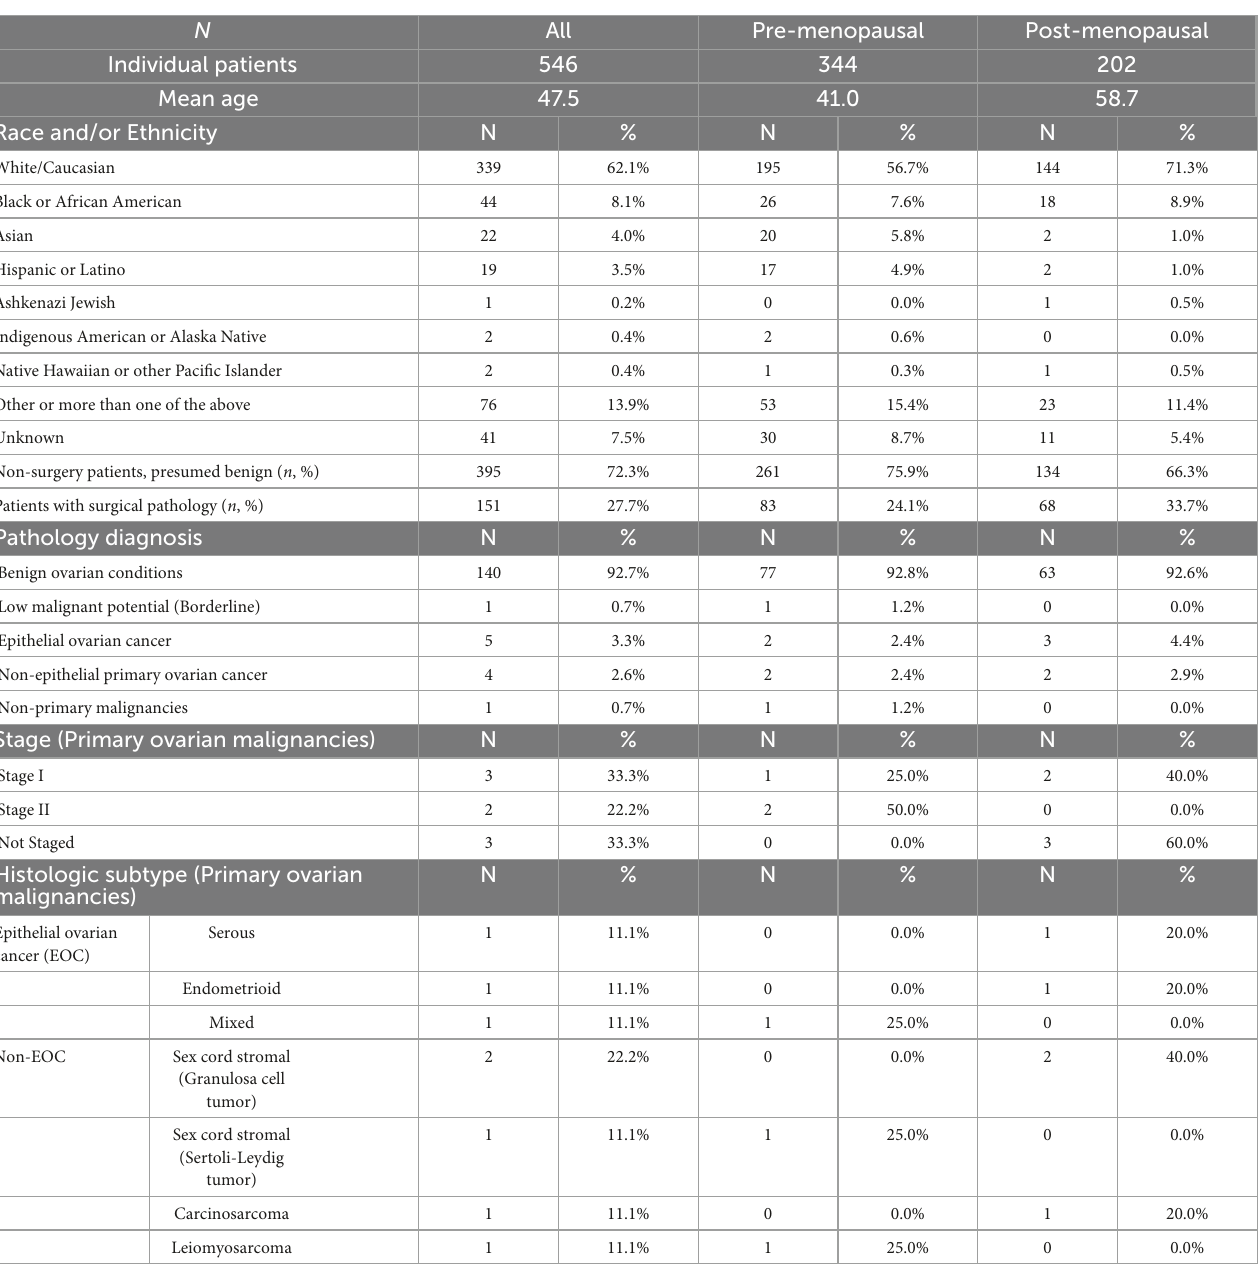
TABLE 2 Prospective study patient demographic and clinical